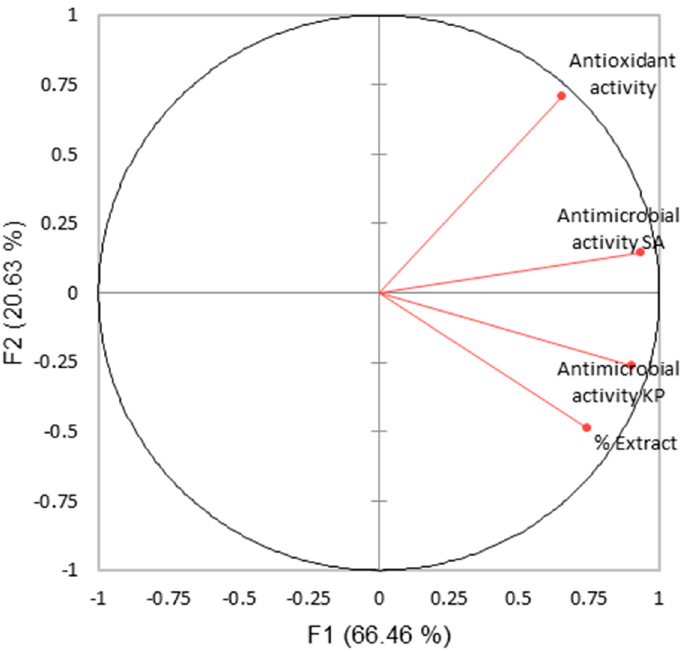
Figure 11. PCA biplot for the extract content, and the antioxidant and antimicrobial